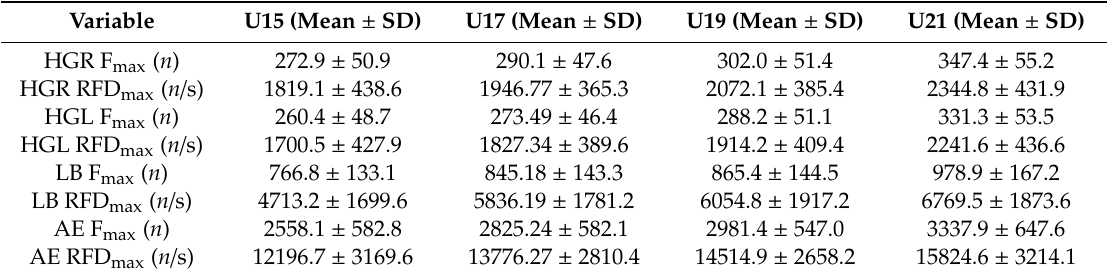
Table 3. Descriptive statistics of female subjects’ isometric strength.